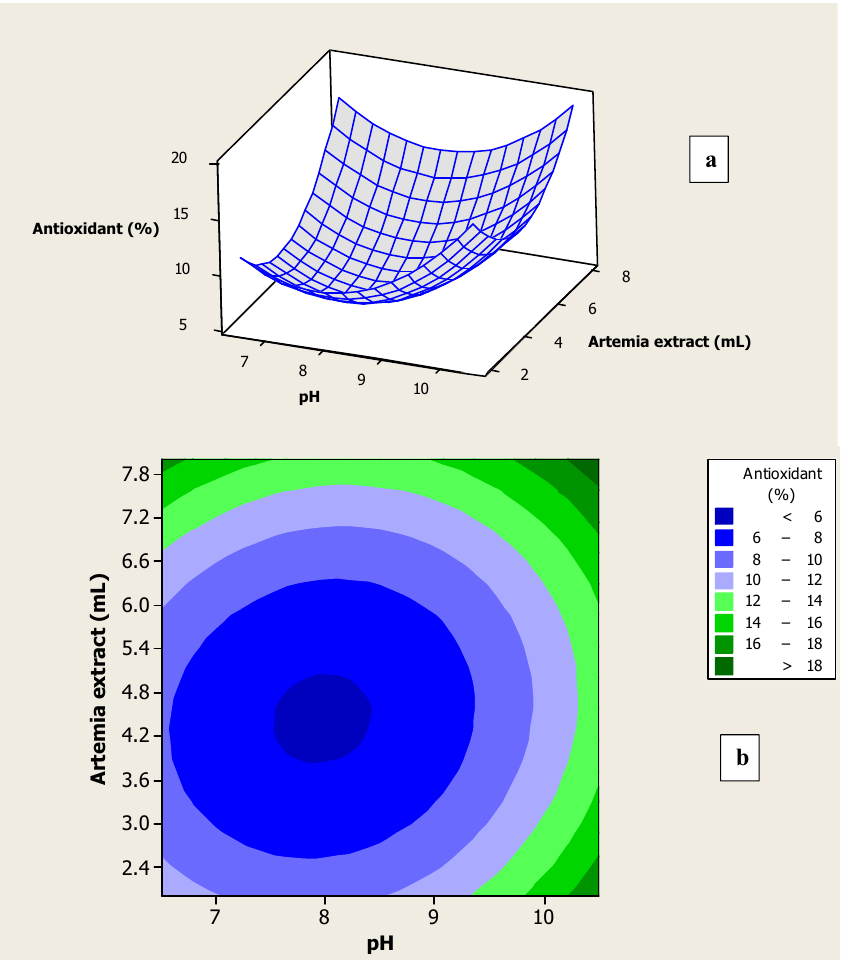
Figure 5: Surface plot ( a ) and contour plot ( b ) for antioxidant activity of the fabricated Au NPs as a function of amount and pH of the prepared A. urumiana